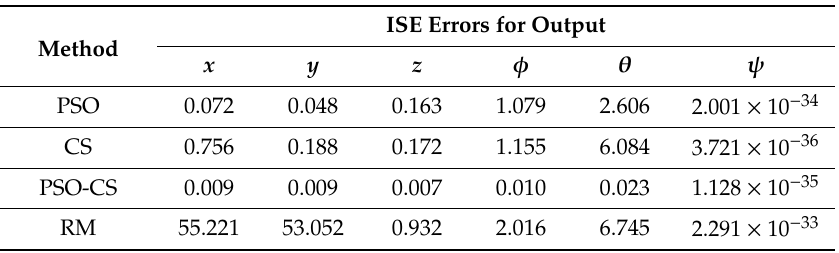
Table 8. Errors (ISE-Integral Square Error) obtained with Particle Swarm Optimization (PSO), Cuckoo Search (CS), Particle Swarm Optimization-Cuckoo Search (PSO-CS), and Reference Model (RM) for the quadrotor with disturbance (helical